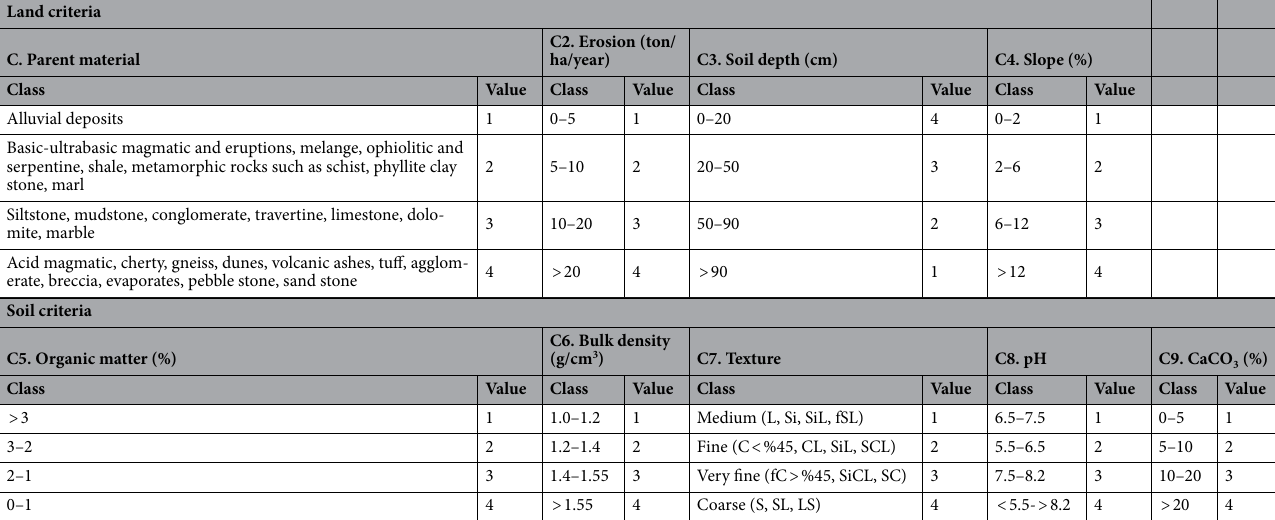
Table 2. Criteria, sub-criteria and their index values used for land suitability classes of agriculture